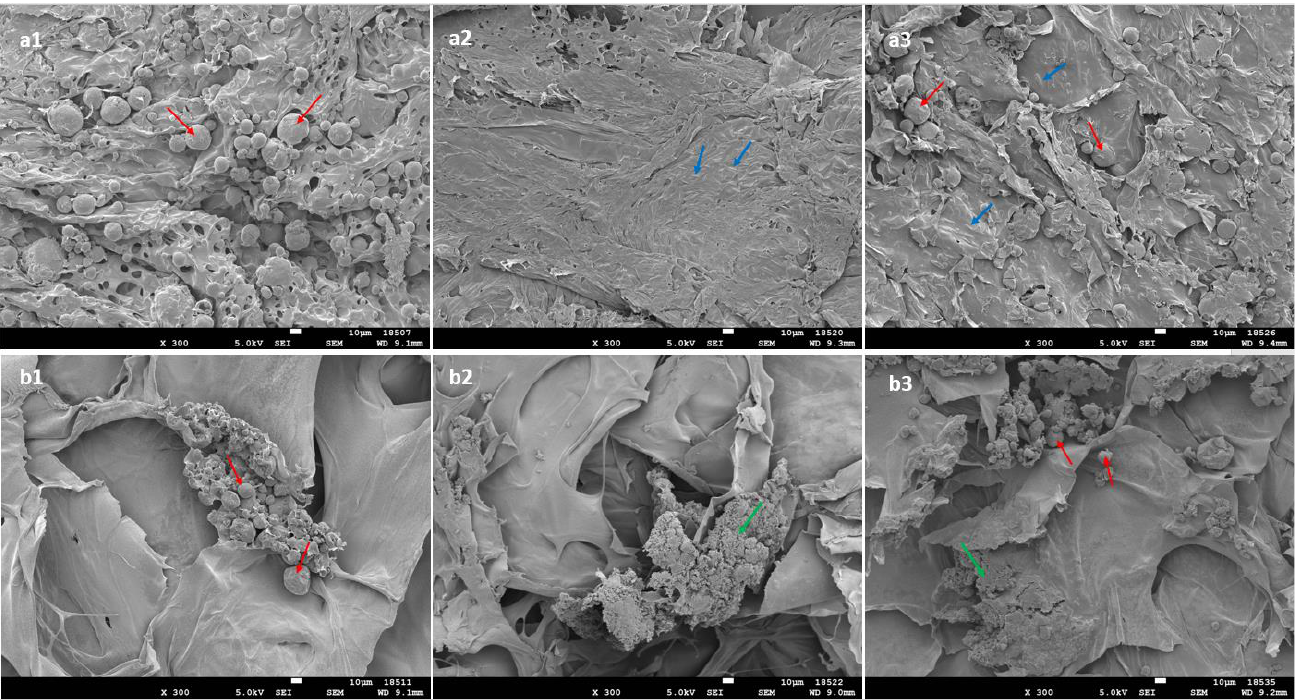
Figure 2. SEM images of the formulations: ( a ) HA-Dop with the addition of ( a1 ) MP, ( a2 ) free ATV, ( a3 ) MP+free ATV; ( b ) Belotero Balance ® with the addition of ( b1 ) MP, ( b2 ) free ATV, ( b3 ) MP+free ATV. Red arrows indicate MP; blue arrows: crystals of free ATV; green arrows: aggregates of ATV crystals. Scale bar: 10 μm; magnification: ×300.